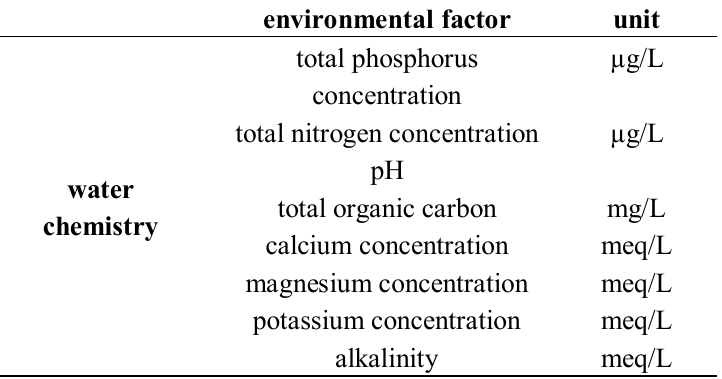
Table 2. Variables considered for model calibration. Variables in bold were used in model calibration, other removed due to high